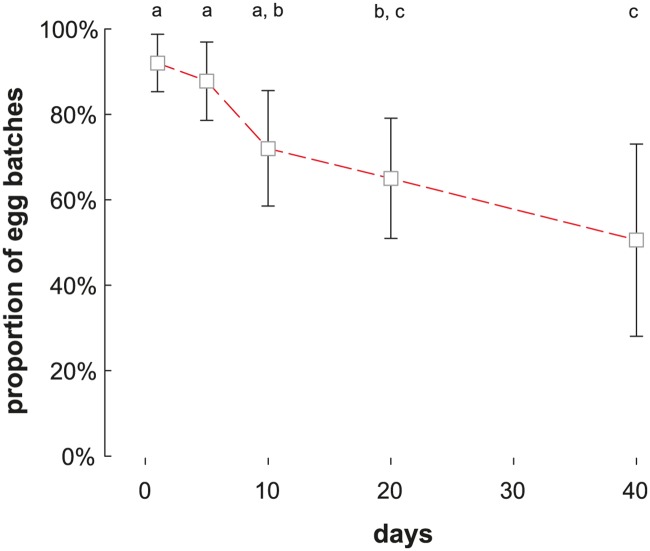
Proportion (±2SE) of Cx. quinquefasciatus egg rafts oviposited in SPLATbacAHD treated water over time after application.Means sharing the same letter indicate no significant differences (Fisher LSD multiple comparisons, p > 0.05).